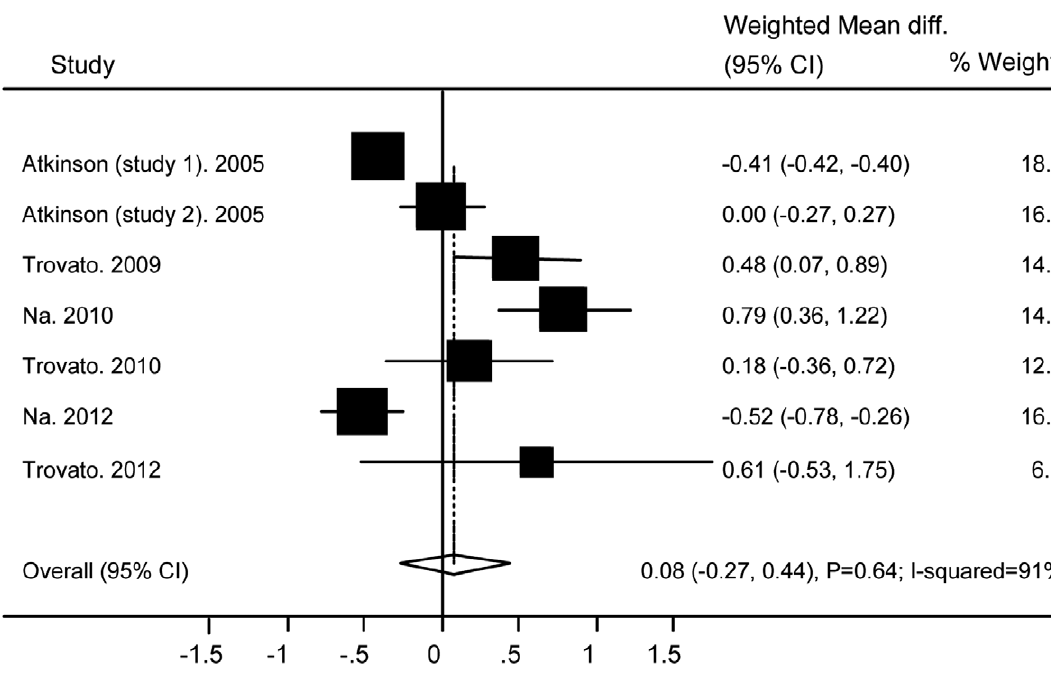
Figure 4. Association of Ad36 with Triglyceride.